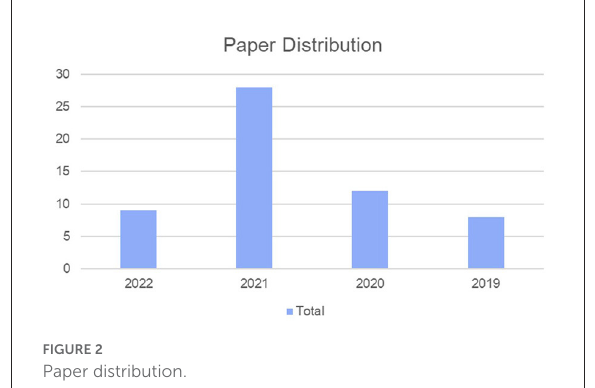
FIGURE2 Paper distribution.